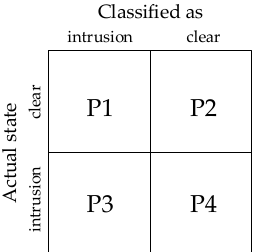
Figure 6. The modified receiver.